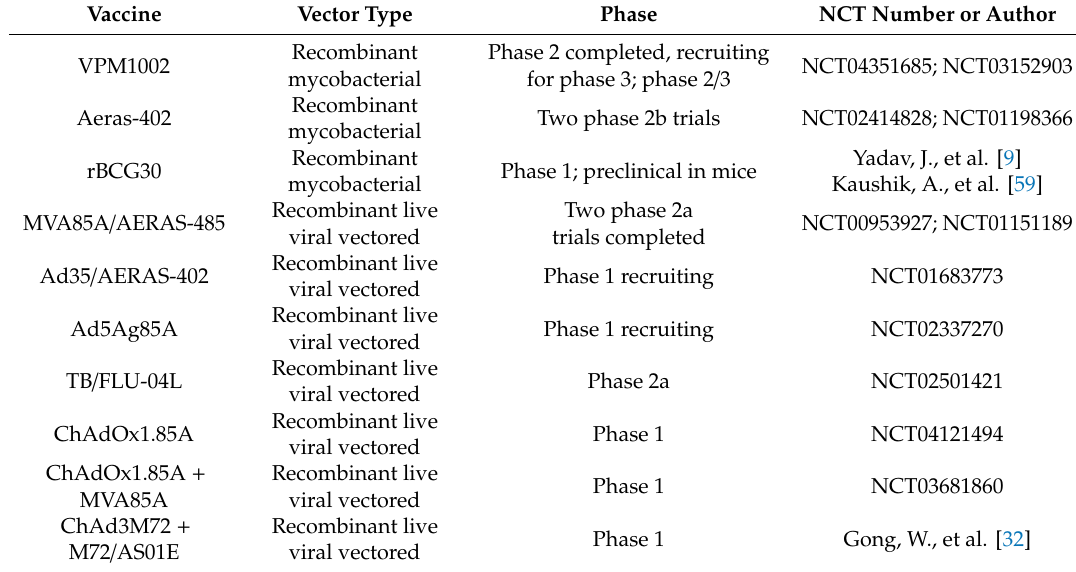
Table 2. Recombinant vaccines in clinical trials.